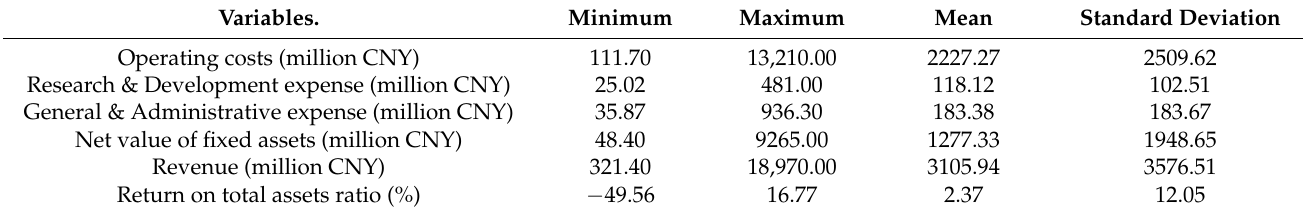
Table 6. Descriptive statistics of selected variables for 34 listed LED energy enterprises in 2019.